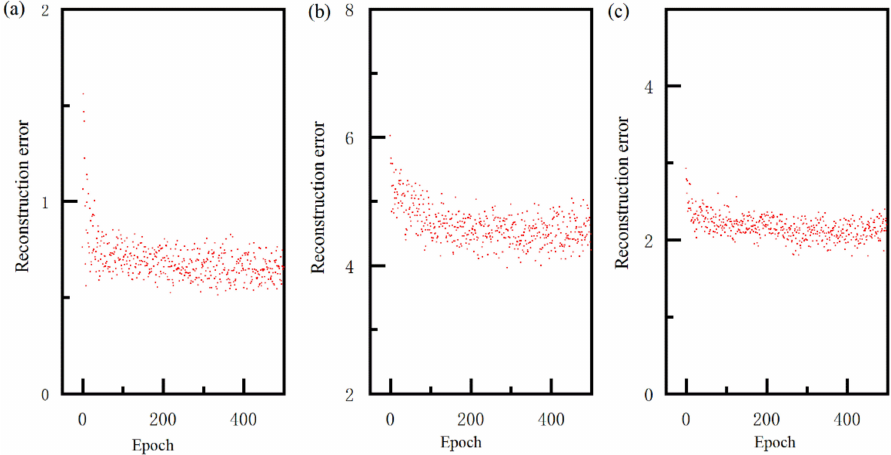
Figure 7. Reconstruction error of first GRBM ( a ), second GRBM ( b ) and third GRBM ( c ).